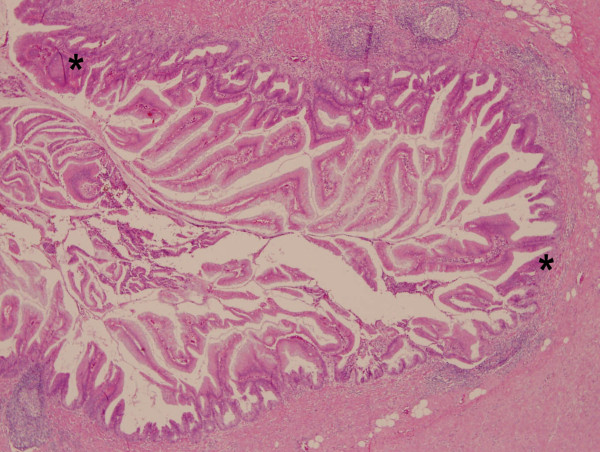
The appendix tissue reveals villous adenoma with moderate to severe dysplasia (asterisk) located suppurative appendicitis. (Hematoxylin and eosin stain, original magnification, × 400).